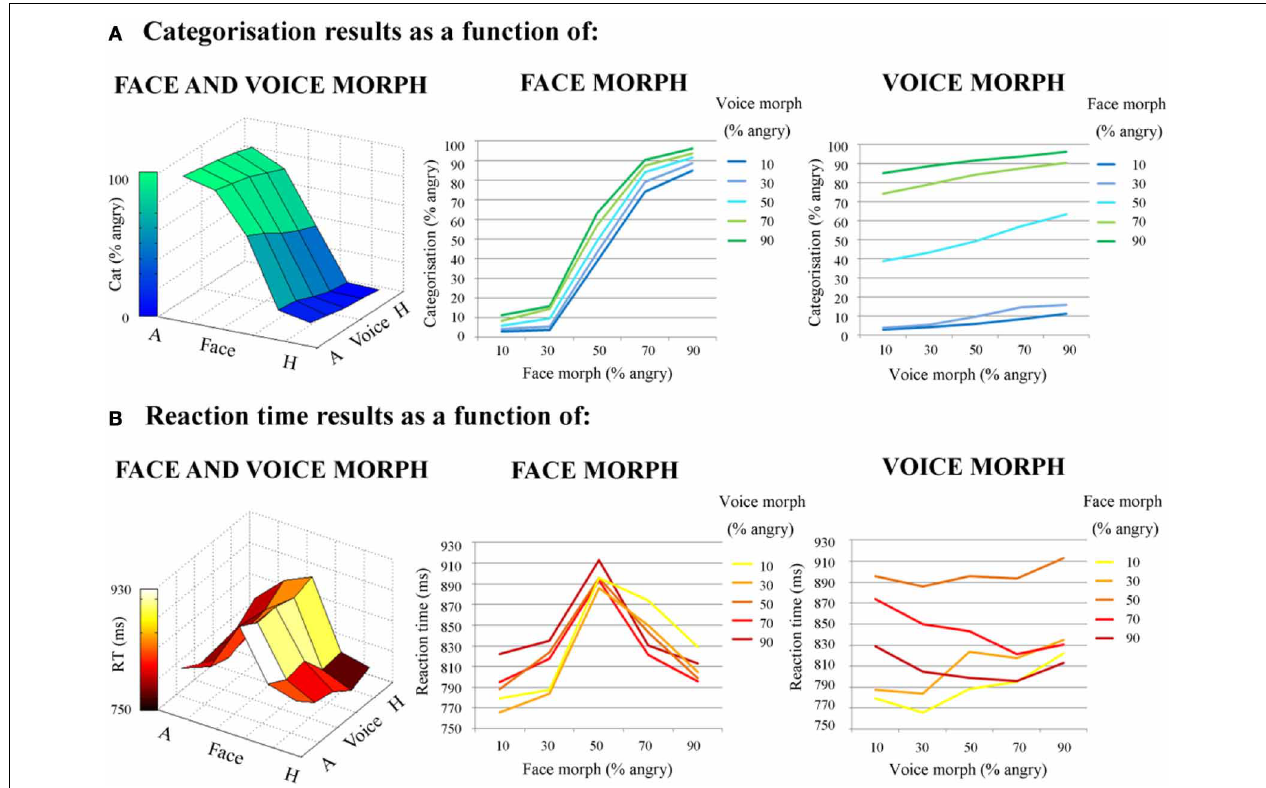
FIGURE 4 | Behavioral results; direct effects of face and voice emotion morph. (A) Categorization results. Categorization (% angry responses) as a function of face morph (middle panel); voice morph (right panel) and both (left panel). (B) Reaction times results. Reaction time (ms) as a function of face morph (middle panel); voice morph